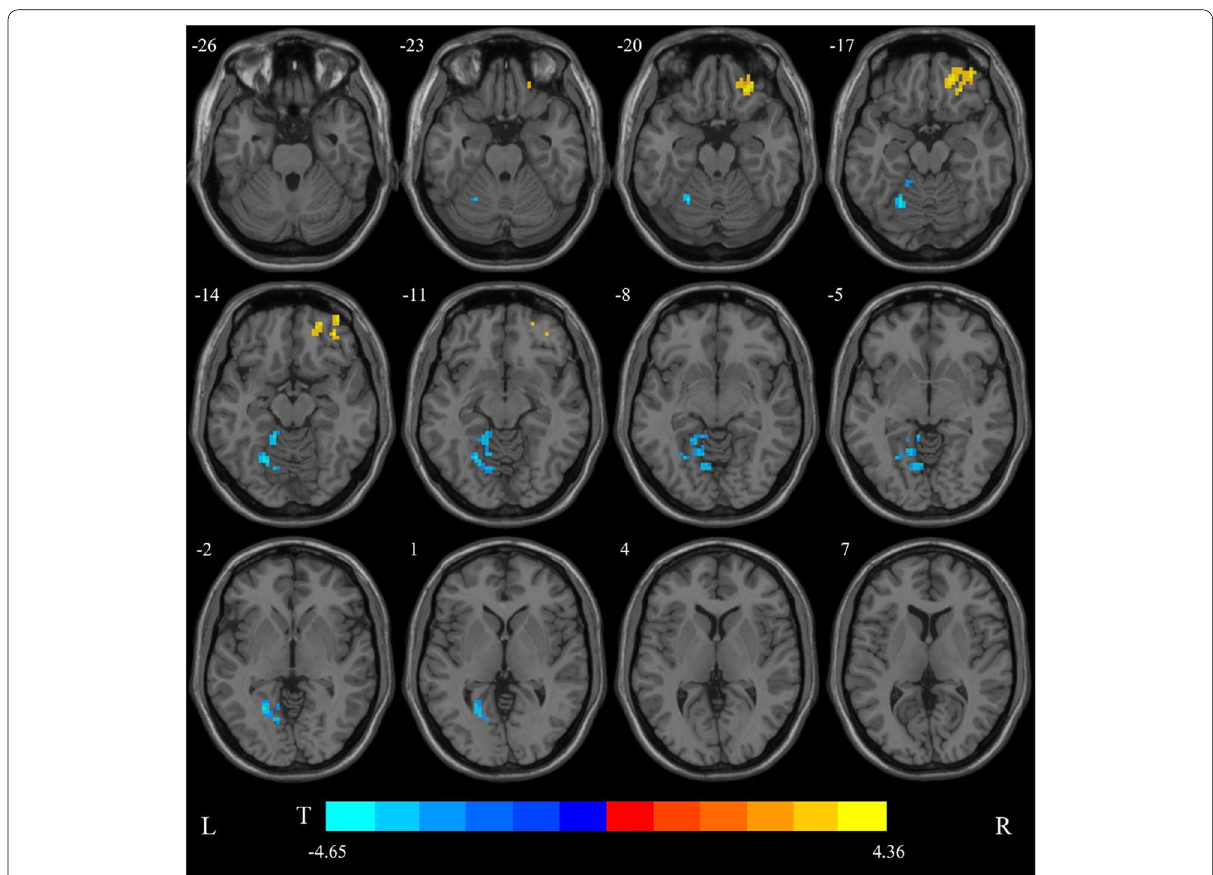
Fig. 3 The group differences of degree centrality (DC) between juvenile myoclonic epilepsy patients with monotherapy and healthy controls. Cold colors indicate decreased DC in the left fusiform/lingual gyrus, the right inferior parietal lobe, and cerebellum, Warm colors indicate an increase of DC in the right orbitofrontal cortex (voxel-level P < 0.005, cluster-level P < 0.05, corrected for Gaussian random field